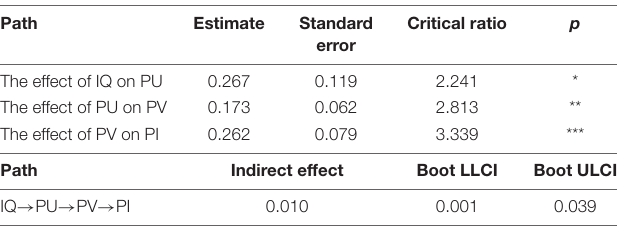
TABLE 3 | Results of path analysis 3.